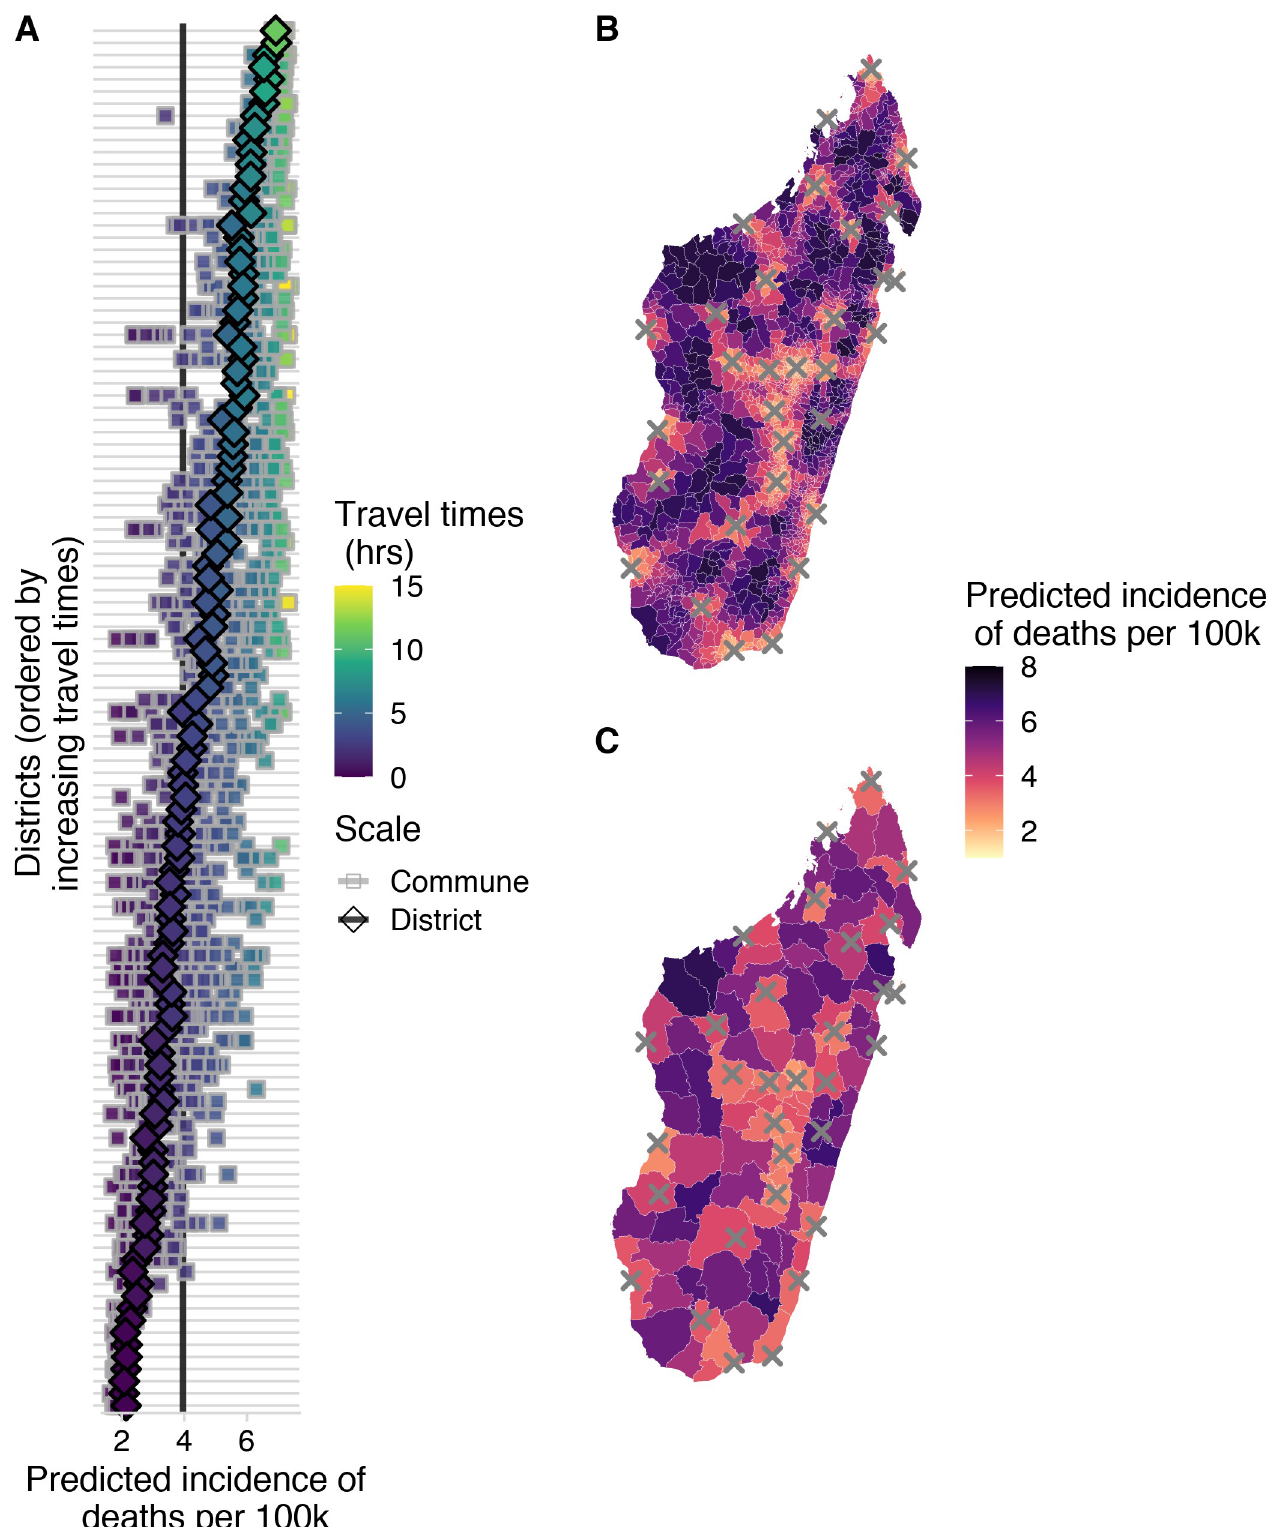
Fig 5. Spatial variation in predicted incidence of human rabies deaths per 100,000 persons. (A) for each district (y-axis) in Madagascar. Diamonds show the predicted incidence for the district model and squares show predicted incidence for the commune model fit to the National data for all communes in a